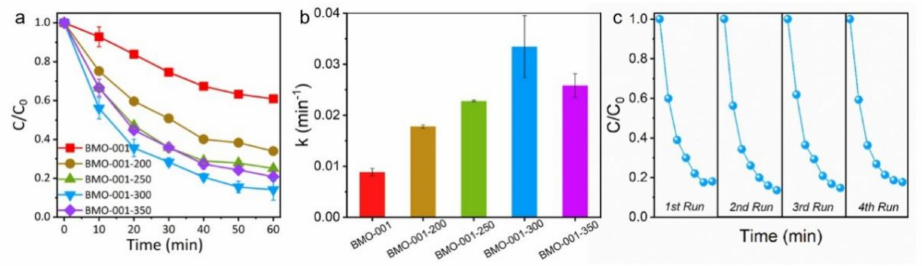
Figure 2. Photocatalytic NaPCP degradation performance curve ( a ) and reaction rate ( b ) on as- prepared Bi 2 MoO 6 samples under visible light irradiation; ( c ) recycle performance of BMO-001-300 for photocatalytic NaPCP